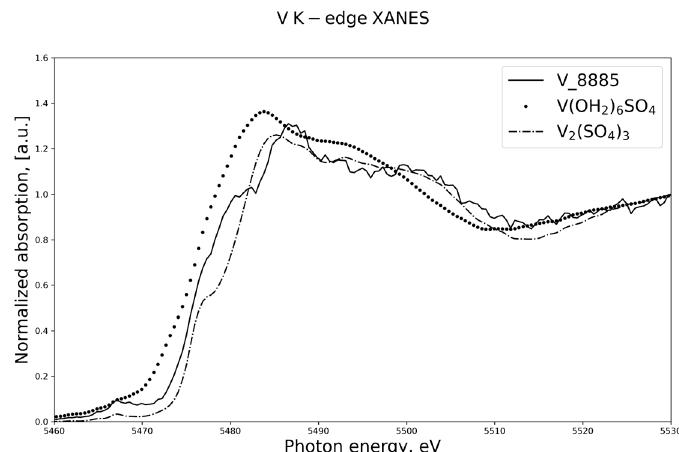
Figure 5. XANES data for the V K -edge of Na 7 V 4 (PO 4 ) 6 (signed as V_8885) with overlayed spectra of VSO 4 · 6H 2 O and V 2 (SO 4 ) 3 .